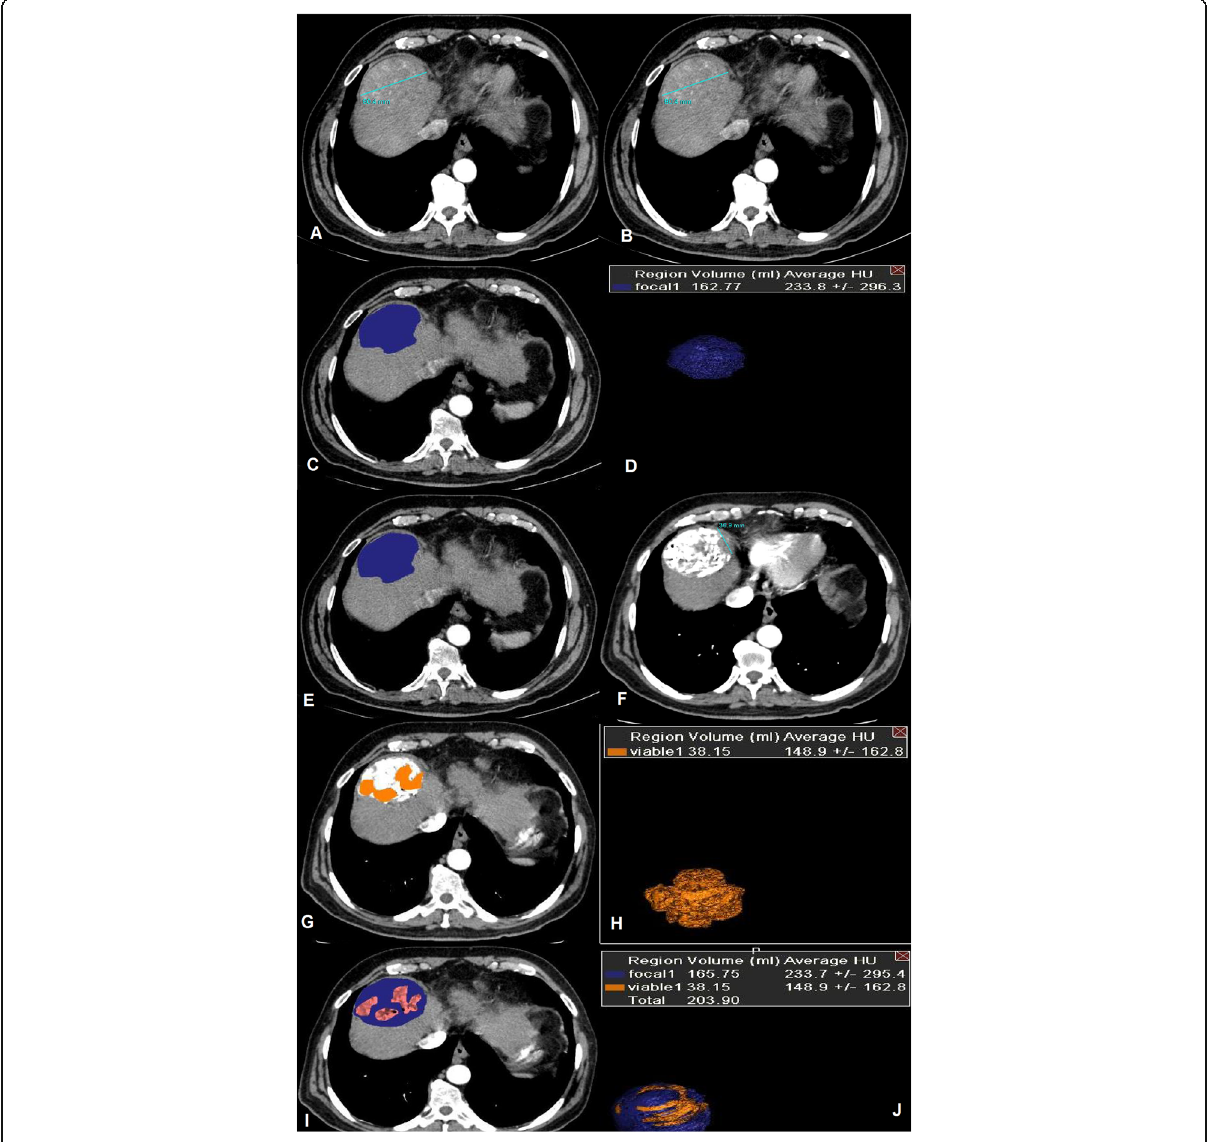
Fig. 2 A 56-year-old male with hepatitis C cirrhosis complicated by development of right lobe HCC. Child Pugh Score: A. BCLB: B. A Pre-TACE axial arterial phase image showing measurement of the lesion according to RECIST, B pre-TACE axial arterial phase image showing measurement of the lesion according to mRECIST and C pre-TACE axial arterial phase image showing measurement of the lesion according to vRECIST, D vRECIST 3D image showing the lesion ’ s volume, E post-TACE images showing lesion ’ s measurement according to RECIST, F measurement according to mRECIST by measuring the diameter of the enhancing component only detected along the lateral margins of the lesion, G volumetric assessment of the viable component only, H 3D image showing the volume of the viable component, I vRECIST of the whole lesion post TACE, and J 3D image of the whole lesion ’ s volume. According to mRECIST, the lesion shows partial response (responder) (> 30% decrease in the diameter of viable component), and also according to vRECIST, the lesion shows partial response (responder) (> 65% decrease in the diameter of viable enhancing